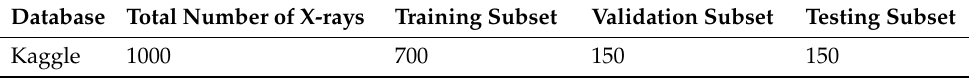
Table 3. Details of the test dataset for the BoxENet Segmentation